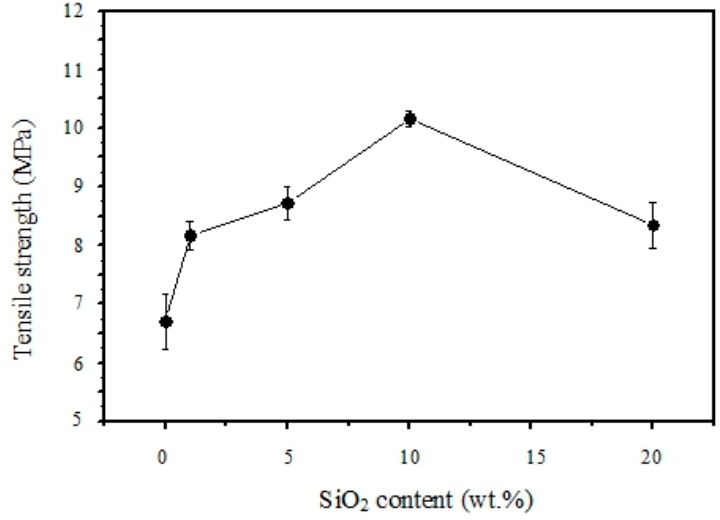
Figure 10. Effects of SiO 2 content on the mechanical tensile strength of composite membranes at room temperature.